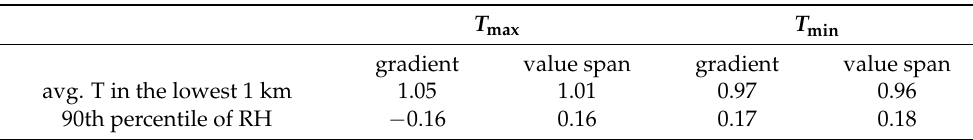
Table 2. The result of the two XAI methods for the same-day forecast of T max and T min using NN Setup E. The shown values of gradient and value span were averaged over all the test cases and 50 realizations of the training.